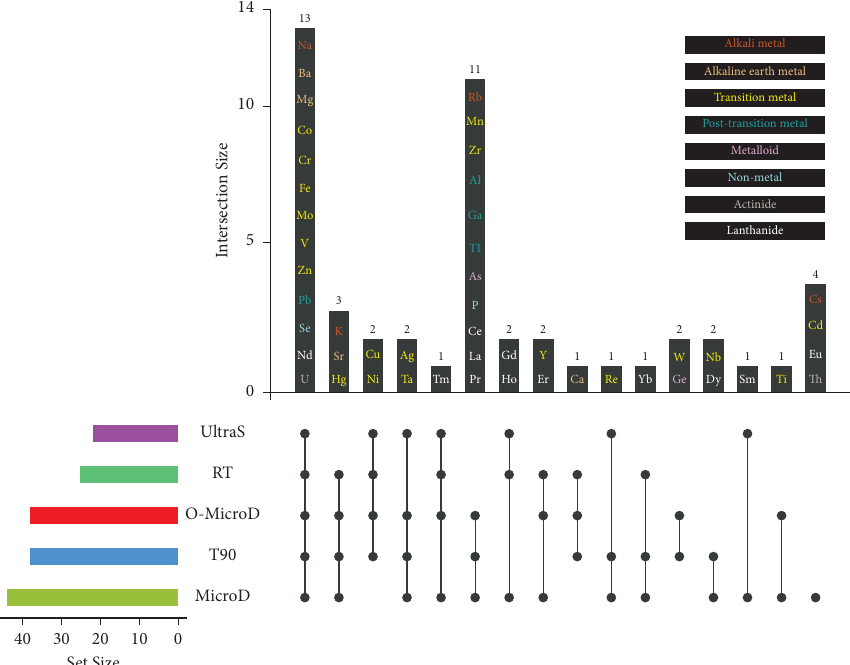
Figure 4: Upset plot of the identifed metal coverage compared across fve diferent digestion methods for human